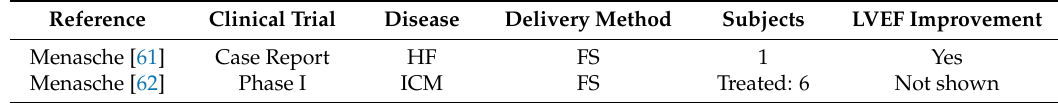
Table 2. Clinical trials with ESCs for cardiac